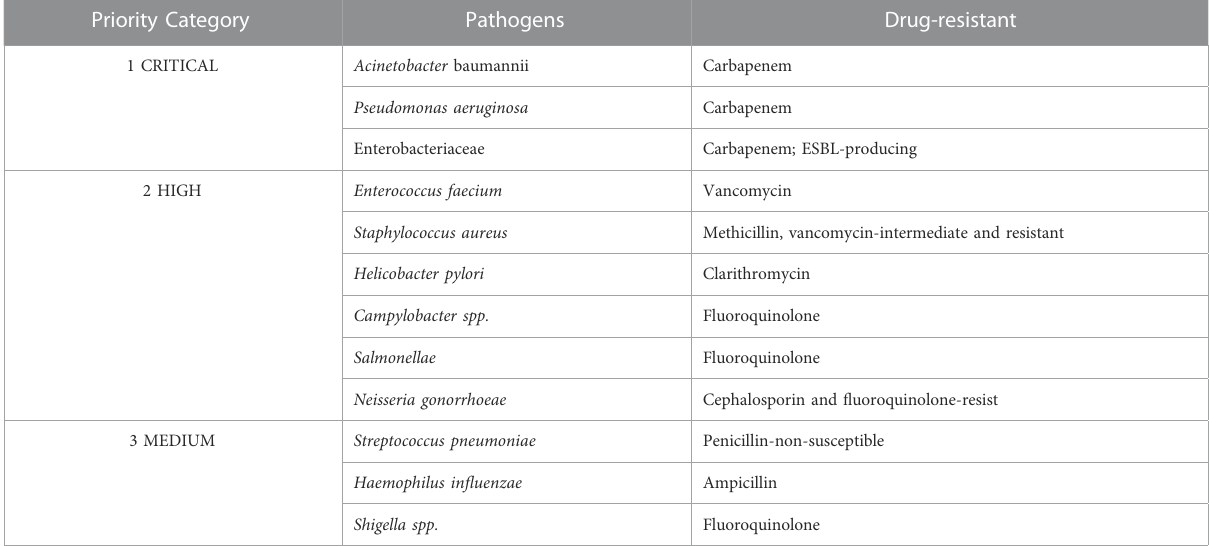
TABLE 1 The bacteria ( n = 12) considered the greatest threat to human health that were added to the priority pathogen list by the